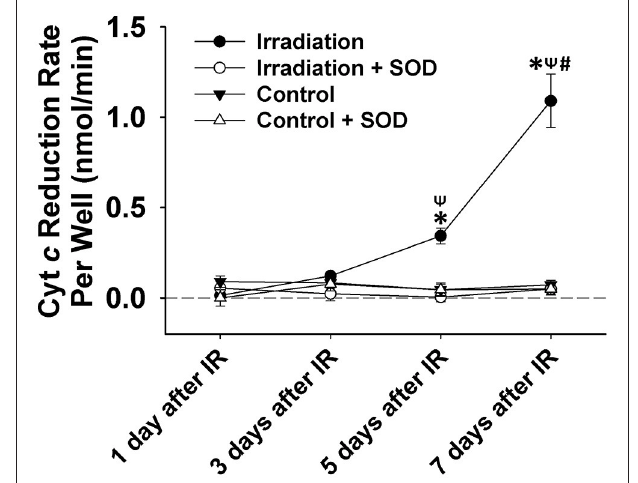
FIGURE 4 | Grouped data showing the cyt c reduction rate per cell culture well (nmol•min − 1 ) during a 5-min observation period in IR and control groups with and without SOD treatment on day 1, 3, 5, and 7 after IR ( n = 6). All data were calibrated by zeroing the “control + SOD” value on day 1. *Significant difference from both control and “irradiation + SOD” group on the same day; ψ Significant difference from day 1 after IR within the same treatment; # Significant difference from both day 3 and day 5 after IR of the same treatment. Sig. (2-tail); p < 0.05.